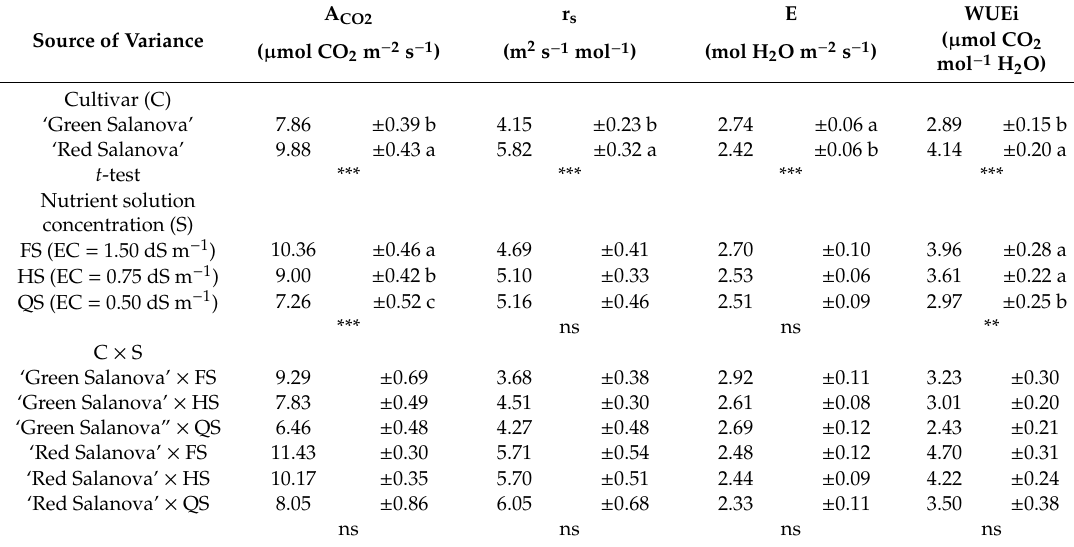
Table 1. E ff ect on the strength of the nutrient solution (full strength: FS; half strength: HS; quarter Strength: QS) on net CO 2 assimilation rate (A CO2 ), stomatal resistance (r s ) stomatal conductance (E), and intrinsic water use e ffi ciency (WUEi). All data are expressed as mean ± s.e.; n = 3.